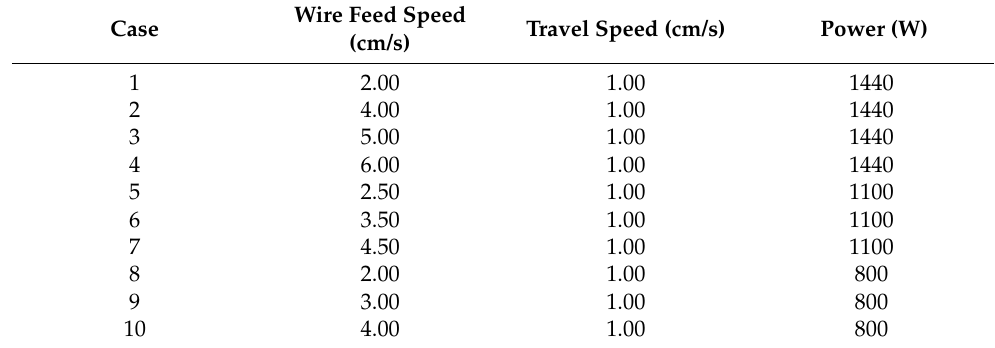
Table 6. Numerical cases to validate the prediction model for the liquid bridge–wire stubbing mode